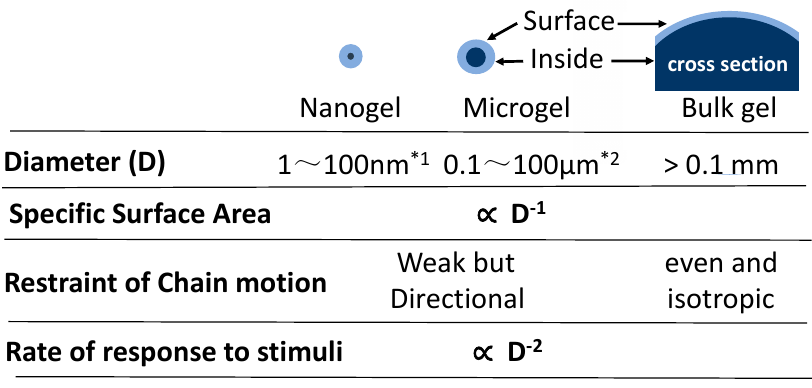
Figure 2. Comparison among nanogel, microgel and bulk gel.